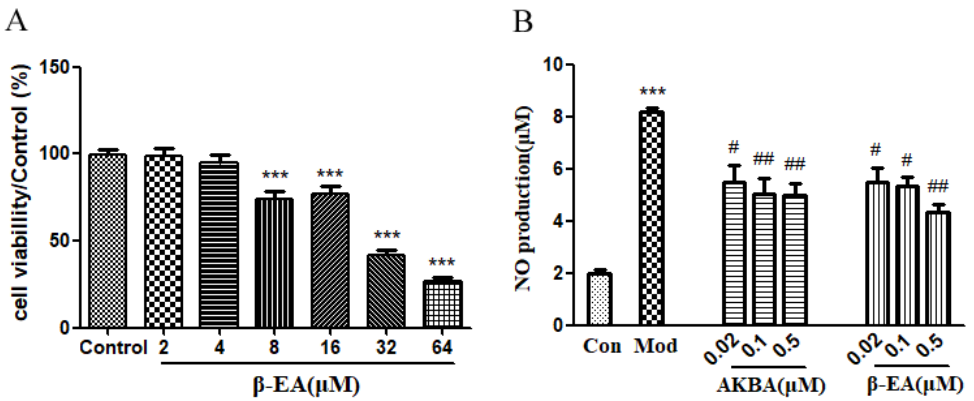
Figure 2. Effects of β -EA on cell viability and LPS induced NO production. RAW 264.7 cells